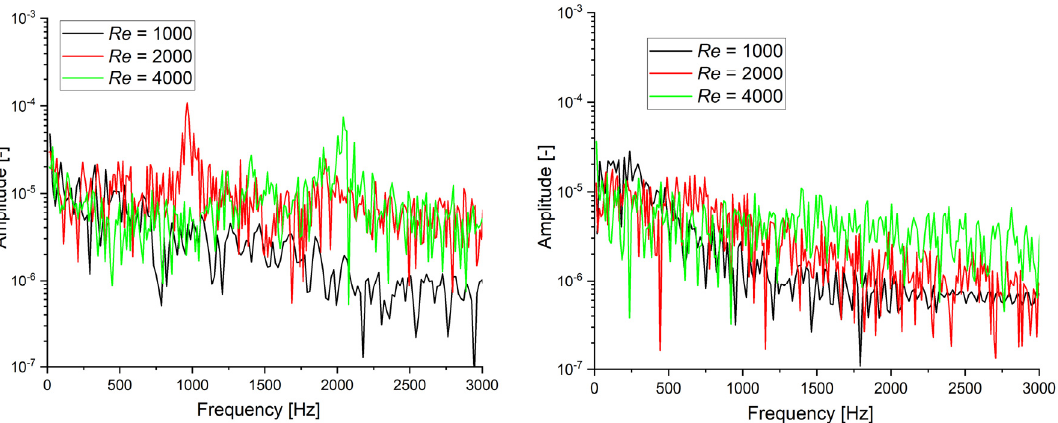
Figure 13. Frequency spectra of air-core diameter fluctuations at location ( left ): d ac2 , ( right ): d ac11 . Laminar simulation.